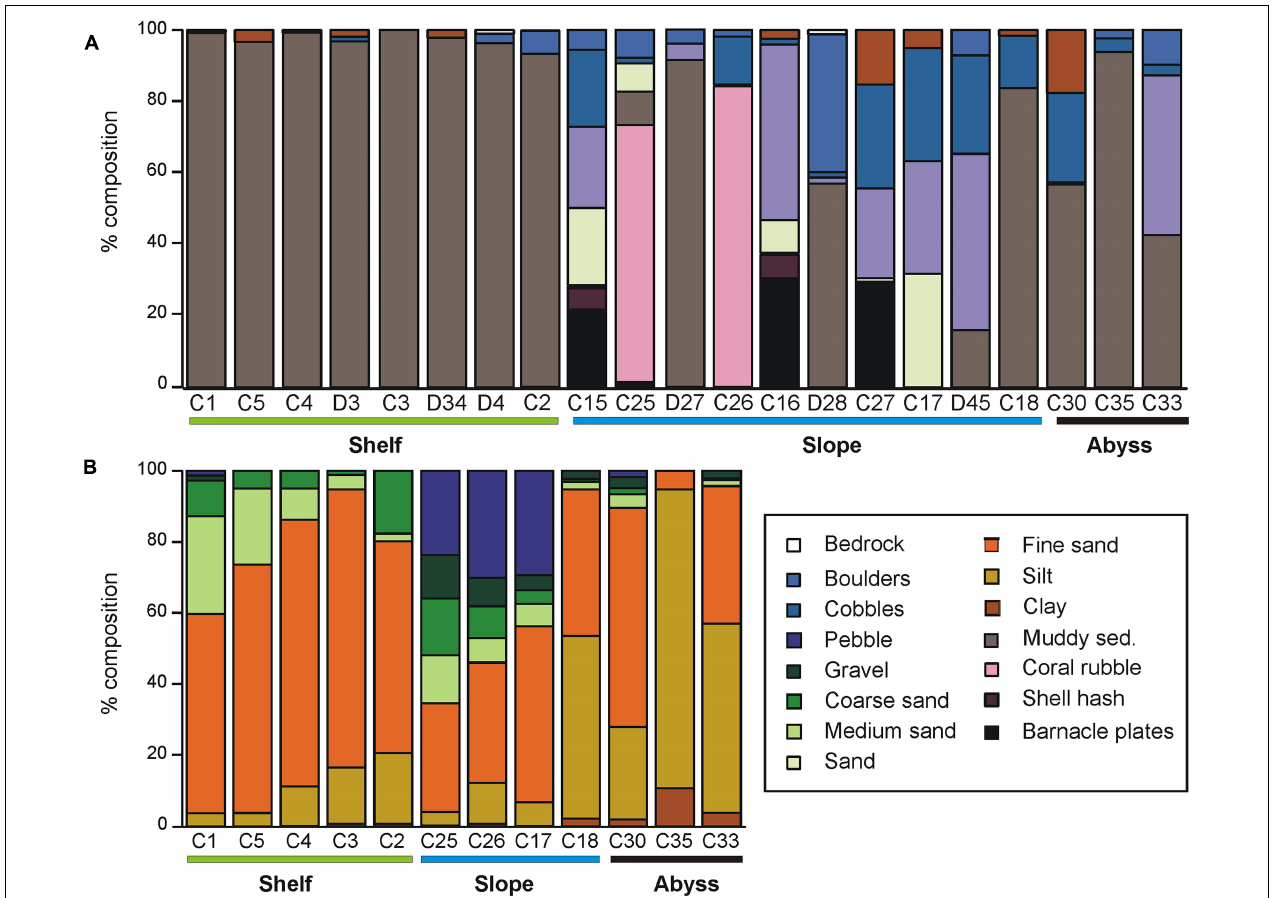
FIGURE 2 | (A) Substrate type determined for Core and Demersal sites from DTIS video, and (B) grain size composition of the multi-core sampled sediments at each Core station. Stations are grouped by environment (Shelf, Slope, Abyss), and, within each environment, are arranged from shallowest to deepest (left to right).